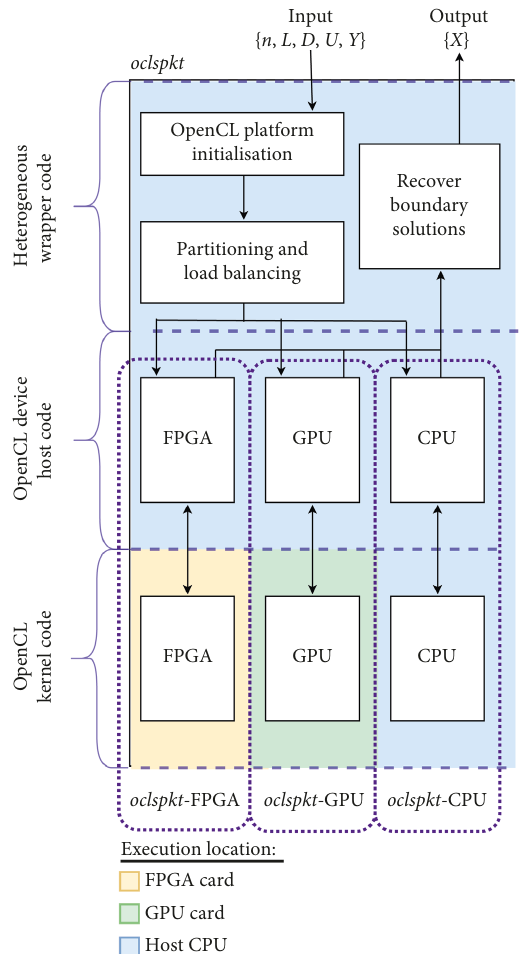
Figure 1: An overview of the anatomy and execution flow of the oclspkt